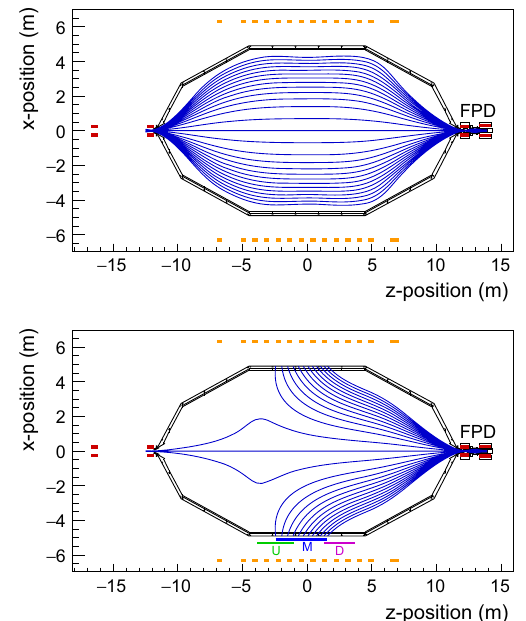
Fig. 4 Symmetric (upper panel) and asymmetric (lower panel) mag- netic field configurations inside the MS. The displayed magnetic field lines(blue)intersecttheFPDpixelrings,andareproducedbythebeam- line solenoids (red) and air-coils (orange). This asymmetric configura- tion is given the name “Asym. M” since the field lines intersect the middle area of the MS ( − 2 . 4m < z < 1 . 6m). This z-range (as well as the ranges for Asym. U and Asym. D, whose magnetic field lines are not drawn) is shown by the labeled, colored line near the bottom of the figure